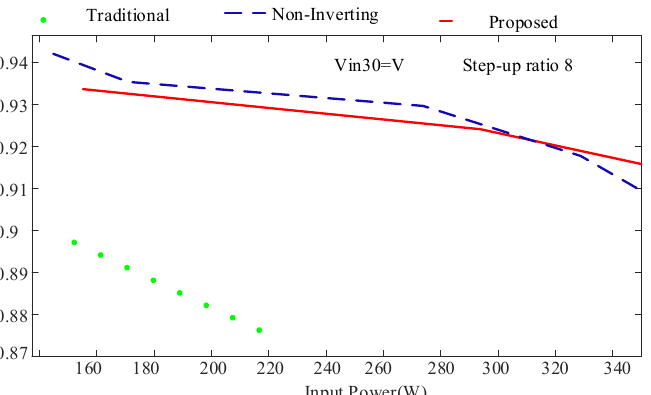
Figure 17. Measured efficiency comparison between the proposed, non-inverting, and traditional buck-boost converter at a step-up ratio of 8.